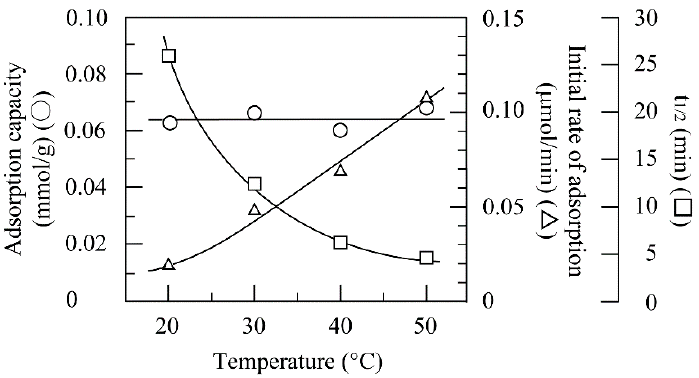
Figure 6. Changes in the adsorption capacity ( 〇 ), initial rate of adsorption ( △ ), and t 1/2 value ( □ ) with the temperature for AEAPTES silica beads with the amount of amino groups of 0.220 mmol/g in a 0.20 mM K 2 Cr 2 O 7 solution at pH 3.0.